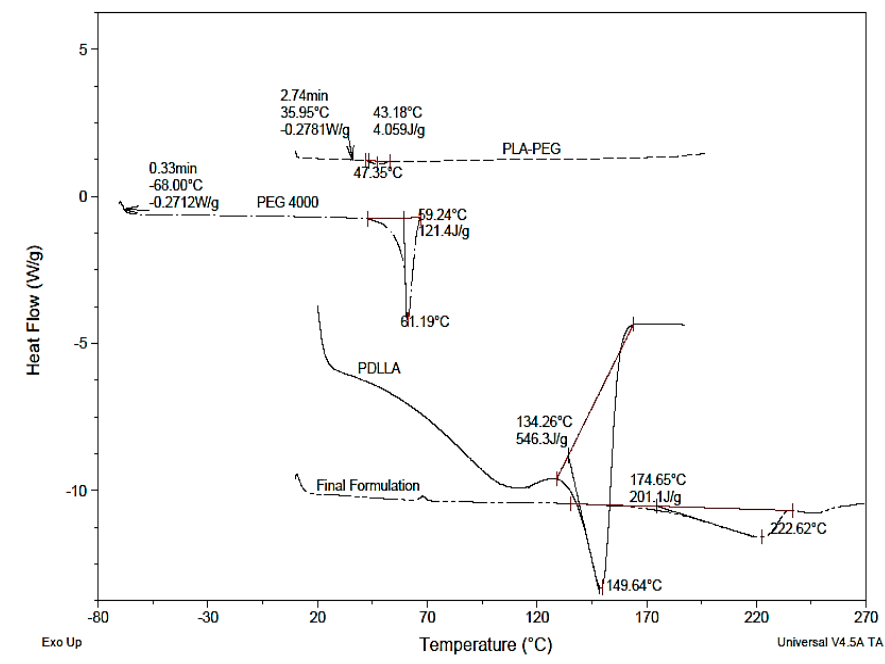
Figure 11. Overlay of DSC thermograms of PDLLA, PEG, PLA-PEG, and final formulation (PLA-PEG-heparin copolymer-encapsulated BCA-loaded LDH).